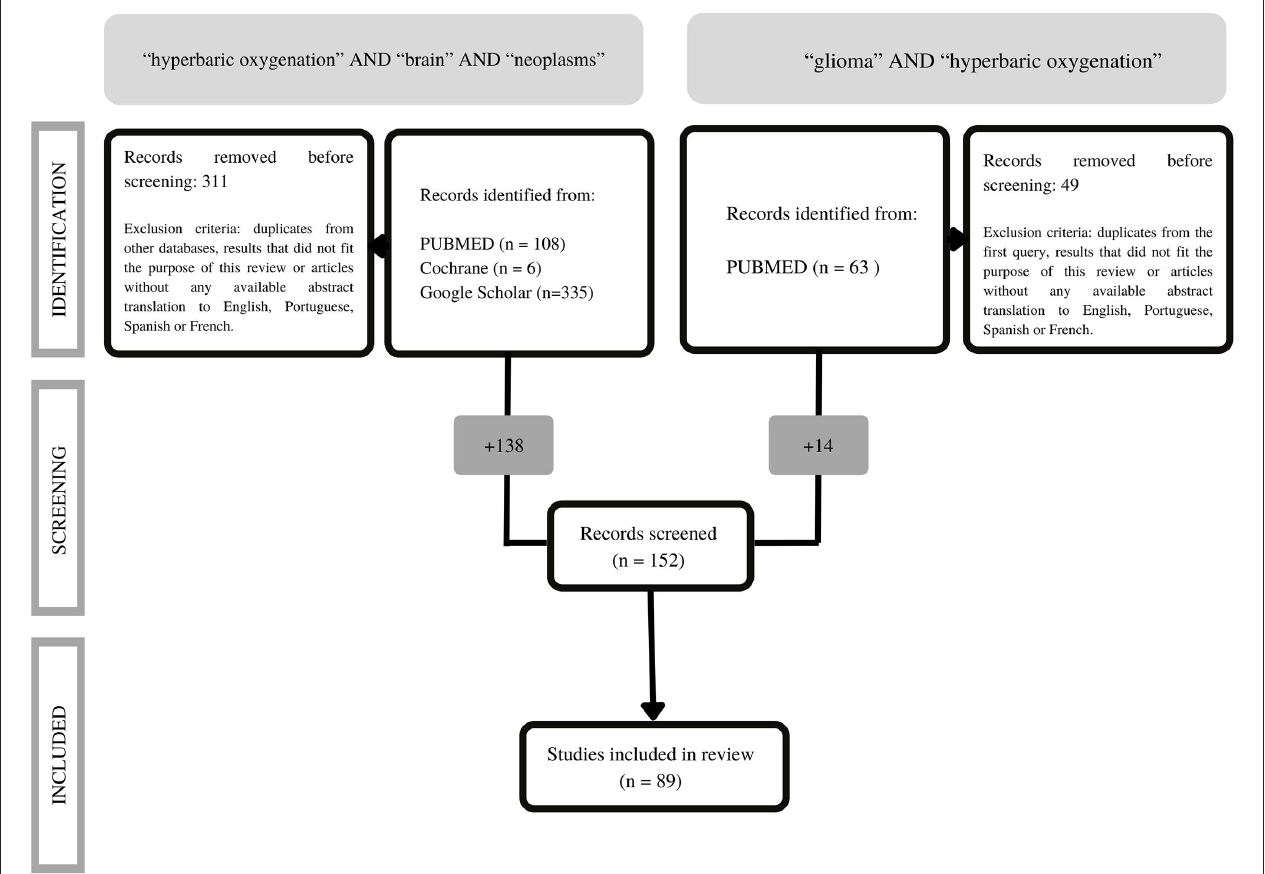
FIGURE 1 | Adaptation of the PRISMA 2020 flow diagram for new systematic reviews [from